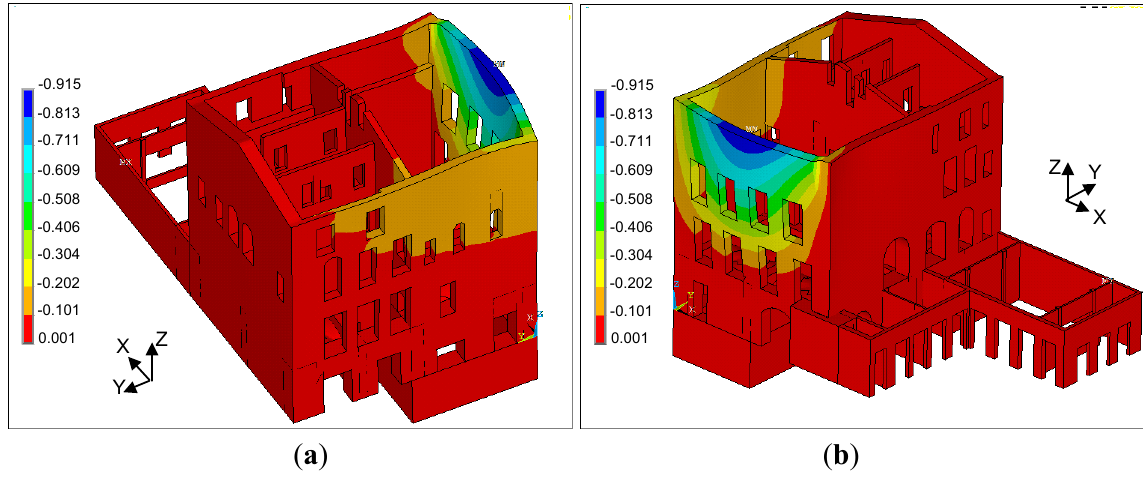
Figure 14. Pushover analysis results ( − Y direction): ( a ), ( b ), ( d ), ( e ) and ( f ) horizontal displacement in Y direction (units are m), ( c ) final cracking and crushing